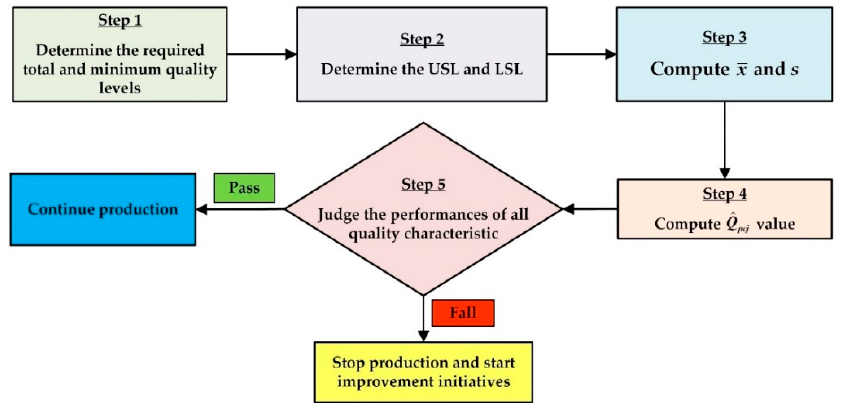
Figure 2. Multi-characteristic quality analysis model (MCQAM).